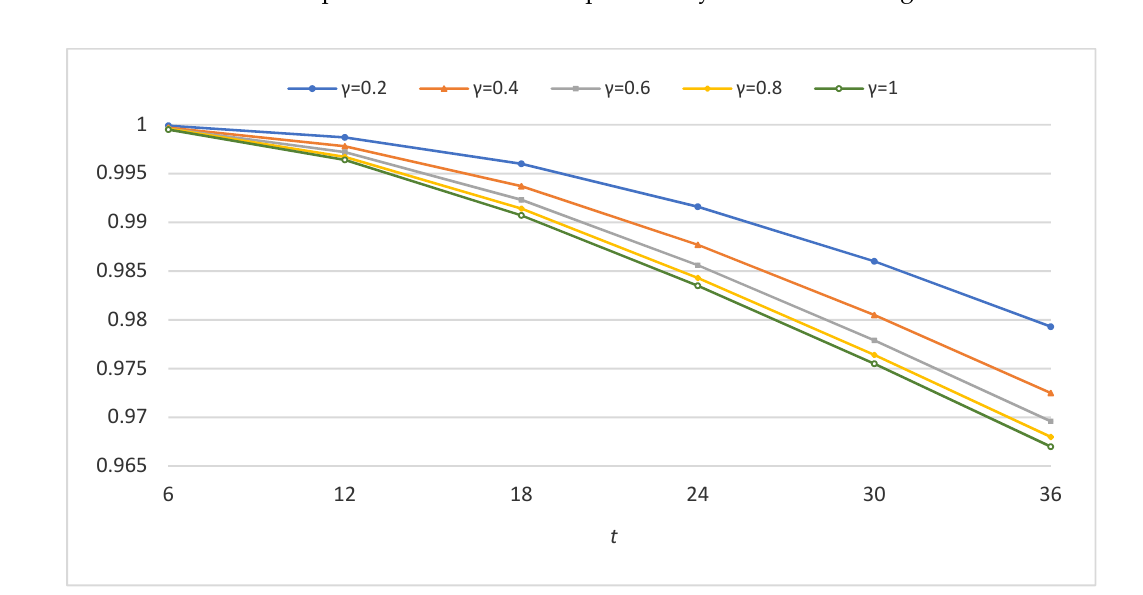
Table 6. The results of the p -value under the